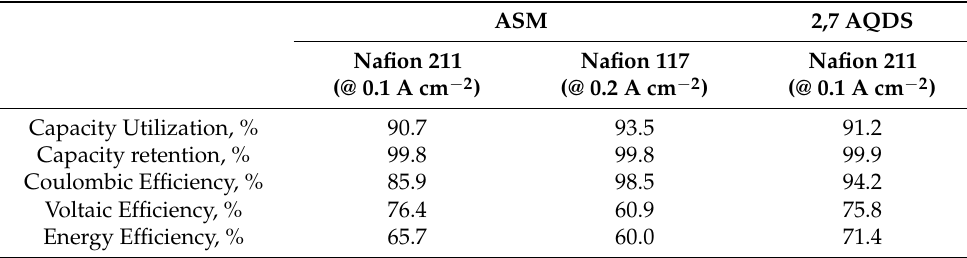
Table 2. Key characteristics of constant-current cycling at 0.1/0.2 A cm − 2 using ASM/ 2,7-AQDS as a negolyte. Membrane Nafion 211/Nafion 117. All values are given for 10th